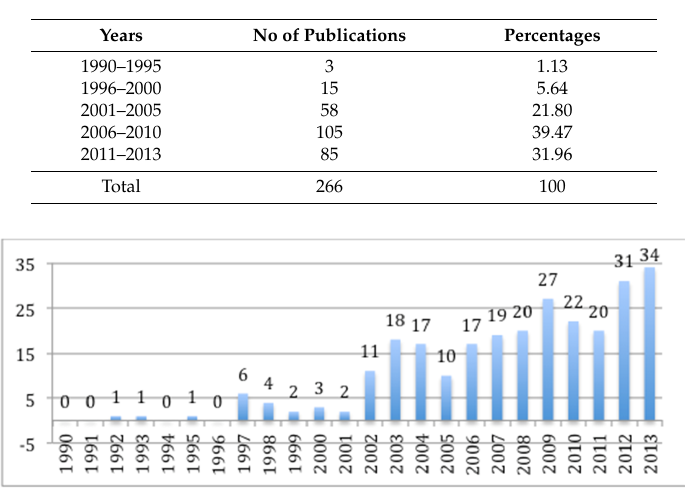
Figure 1. The number of the SLW publications appeared in SSCI and A & HCI indices per year.